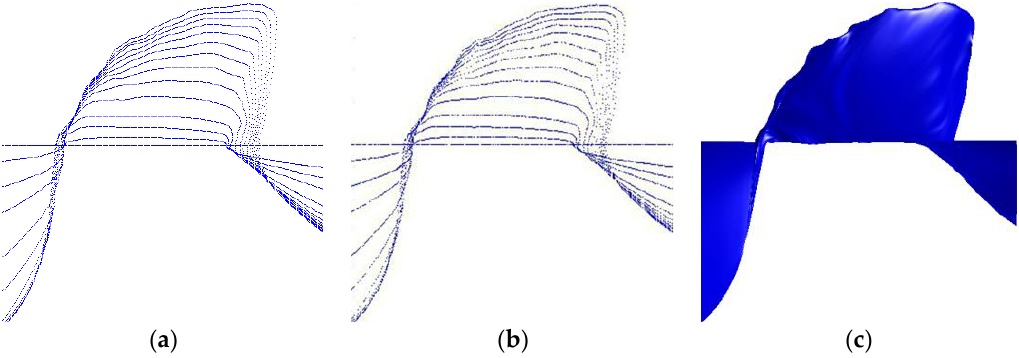
Figure 10. Surface fitting of a pump surface: ( a ) the original grid data; ( b ) the randomly chosen data; ( c ) the fitting NURBS surface.